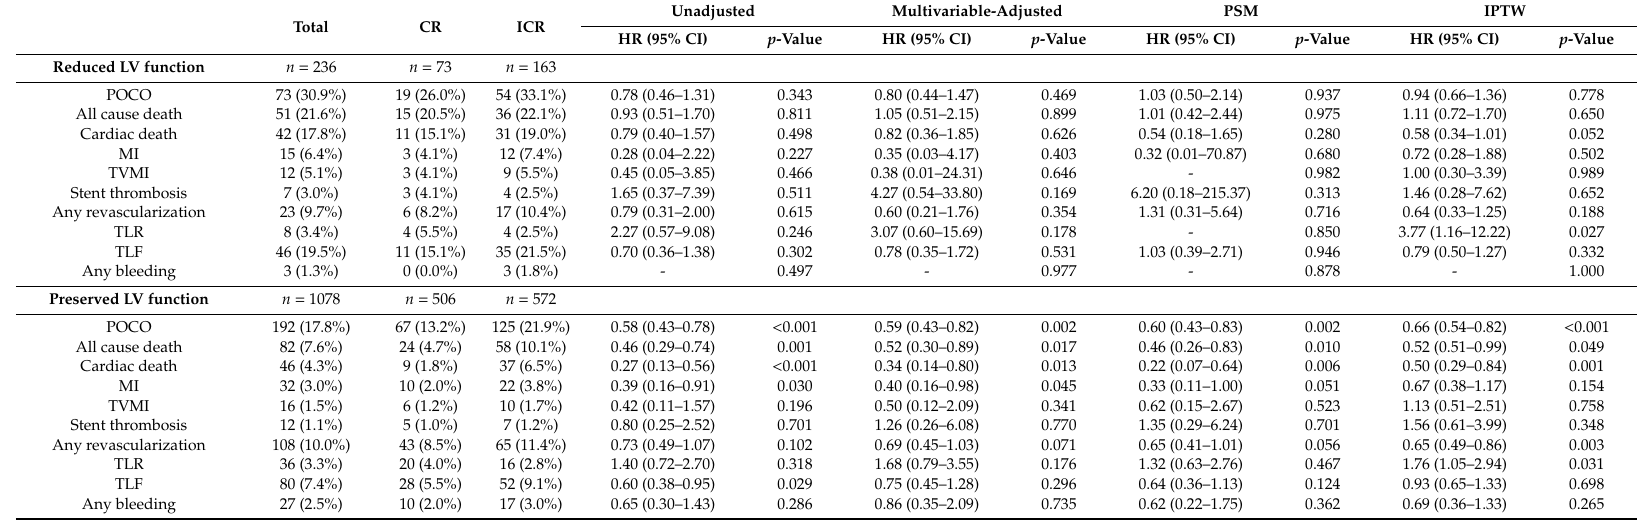
Table 2. Three-year clinical outcomes according to the LV